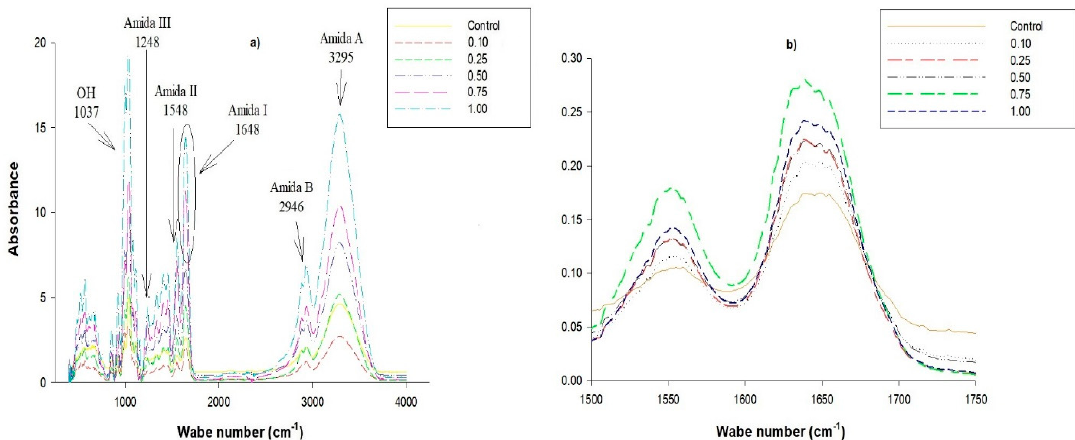
Figure 4. ( a ) FTIR spectra of gelatine films with the presence of bioactive nanoemulsified compounds. ( b ) FTIR spectra of gelatine films showing the representative band of amide II and C = C double bonds.